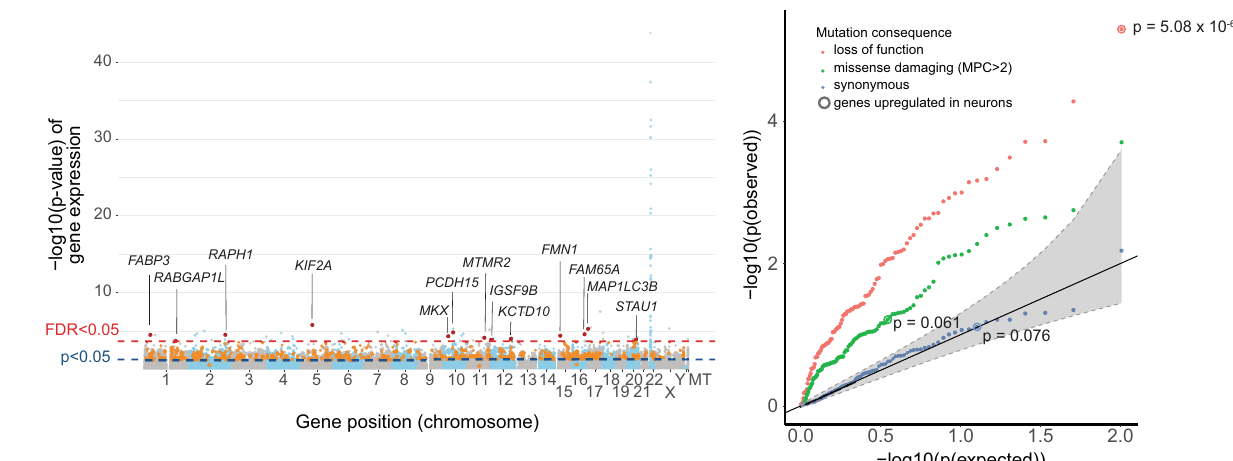
of the random gene lists we sampled (Fig. 3d, red dot black circle;